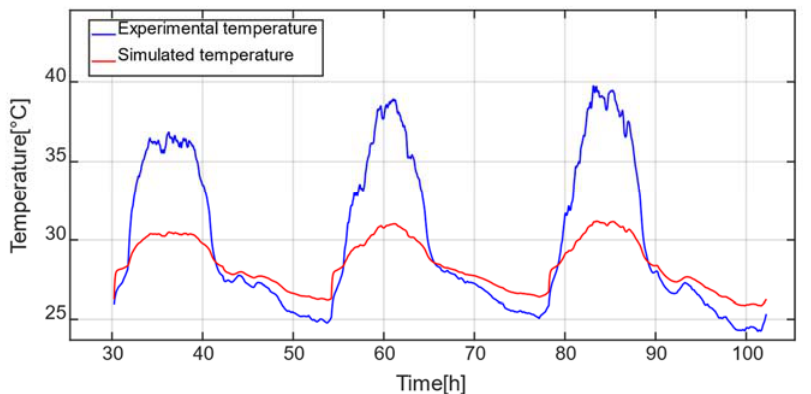
Figure 10. Experimental and simulated temperature with wood reinforcements versus time.